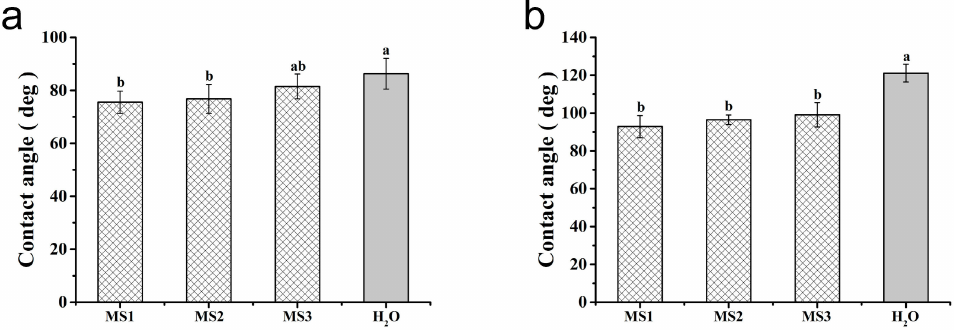
Figure 10. Contact angles of the azoxystrobin microspheres on the leaf surfaces: ( a ) cucumber leaf; ( b ) cabbage leaf. For contact angles on cucumber leaves and cabbage leaves, different lowercase letters indicated statistically significant differences (one-way ANOVA, SNK test, p < 0.05).